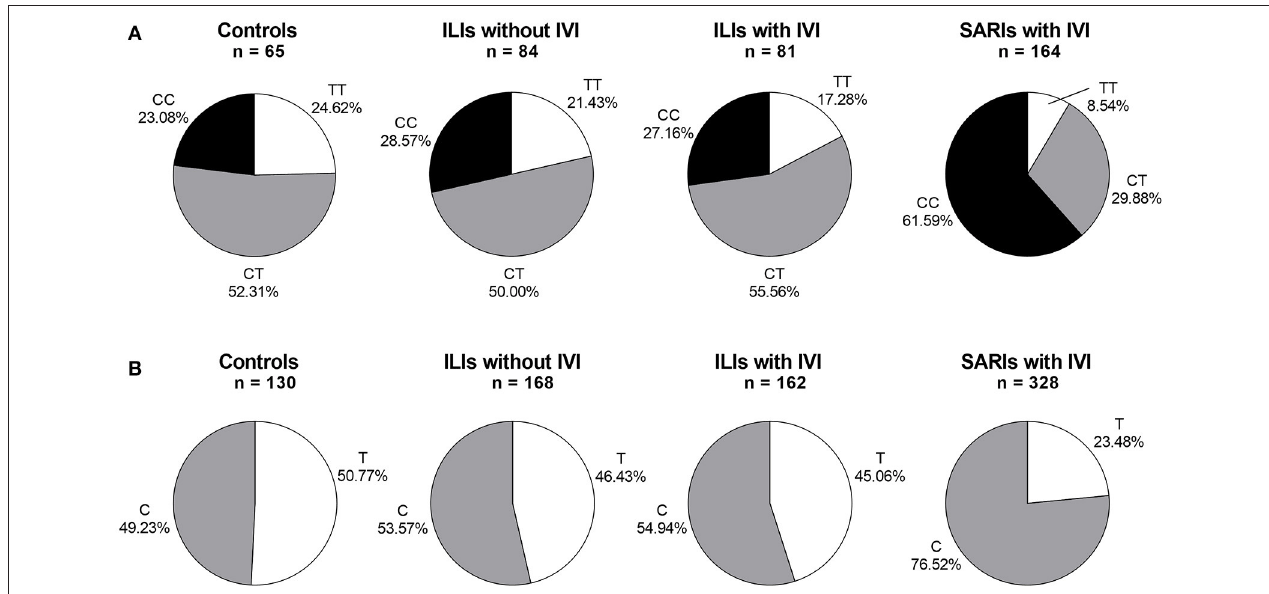
FIGURE 1 | IFITM rs12252 genotypic and allelic frequencies in controls, ILI cases and SARI cases. (A) IFITM rs12252 genotypic frequencies in controls, ILI cases and SARI cases. (B) IFITM rs12252 allelic frequencies in controls, ILI cases and SARI cases. ILI, influenza-like illness, SARI, Severe Acute Respiratory Infection, IVI, influenza virus infection.